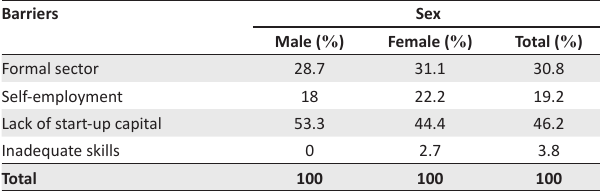
TABLE 2: Barriers to employment by sex ( N = 26 Females 15 and males 11).